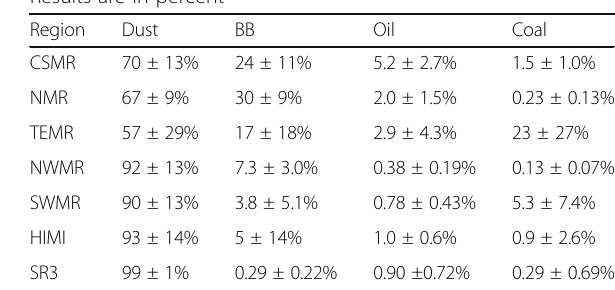
Table 3 A posteriori model estimates of T Fe source apportionment for each region considered, including the Australian marine regions (CSMR, NMR, TEMR, NWMR, and SWMR), as well as regions of the SO (HIMI and SR3). Atmospheric sources considered include dust (Dust), biomass